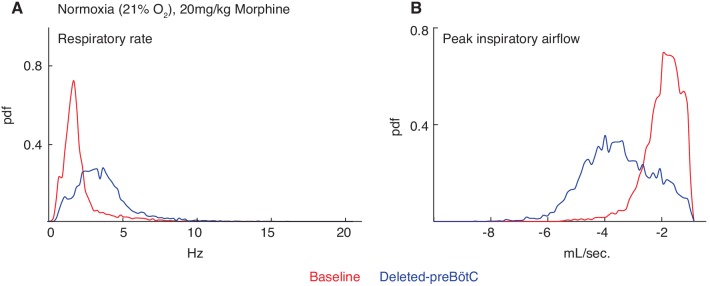
Necessity of the preBötC for complete opioid induced respiratory depression in normoxia.The same animals in Figure 2 were also assayed for OIRD under normoxic instead of hypercapnic conditions. Briefly, breathing is measured 15 min after IP injection of 20 mg/kg morphine in normoxia, animals are injected with a constitutive-Cre AAV into the preBötC bilaterally, and after several weeks re-assayed as above. (A–B) A representative probability density function of respiratory rate (A) and peak inspiratory airflow (ml/sec, (B) of all breaths taken during the 40 min assay while in normoxia after intraperitoneal injection of 20 mg/kg morphine before (red) and after (blue) AAV-Cre injection. The increased respiratory rate and peak inspiratory airflow after bilateral preBötC AAV-Cre injection indicates that the rescue of OIRD observed in hypercapnia also occurs in normoxia.